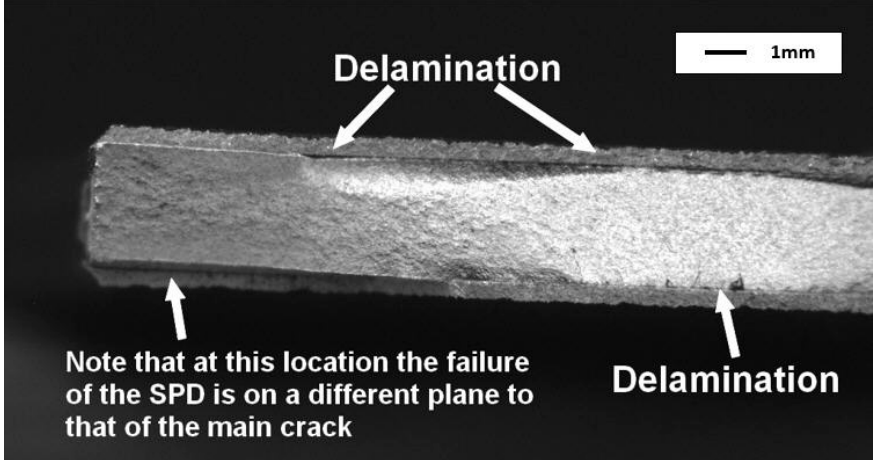
Figure 10. Delamination of specimen S40, which had a 0.5 mm thick 7075 coating, was tested at 25 kN and failed at approximately 124,000 cycles. Note how the failure of the coating is on a different plane to that of the crack in the 2024-T3.